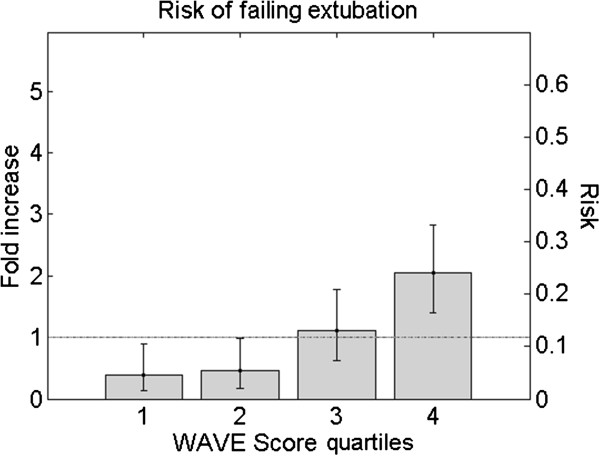
Weaning and variability evaluation (WAVE) score quartile. This figure shows the risk/fold increase in risk of failing extubation associated with each quartile of the population. The risk is defined as the number of patients who failed divided by the total number of patients in a given quartile. The fold increase in risk is the risk divided by the average risk of failure of the dataset (approximately 12%). The total number of patients is 434, therefore each quartile is representative of 108 patients.